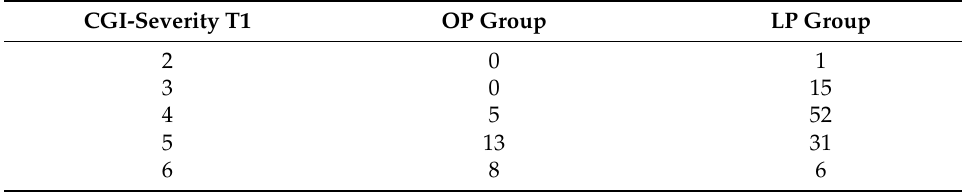
Table 3. CGI-Severity distribution at T1.